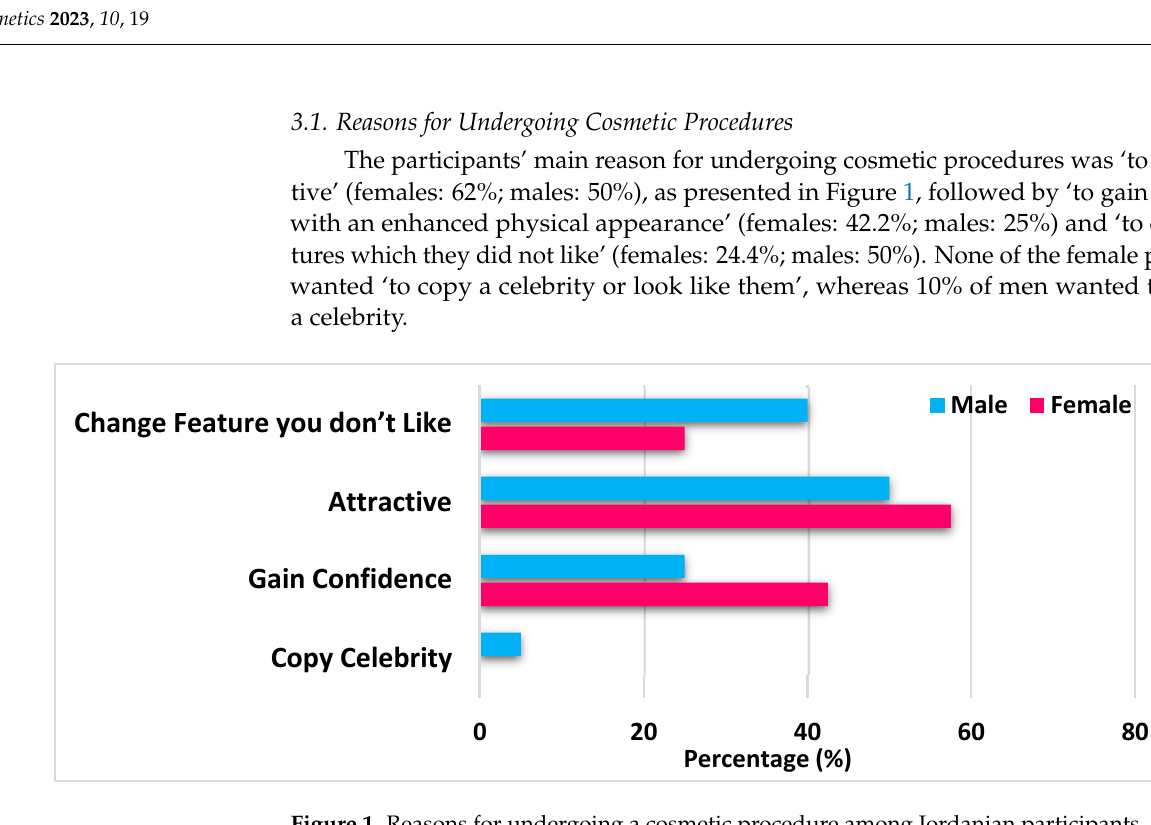
Figure 1. Reasons for undergoing a cosmetic procedure among Jordanian participants.